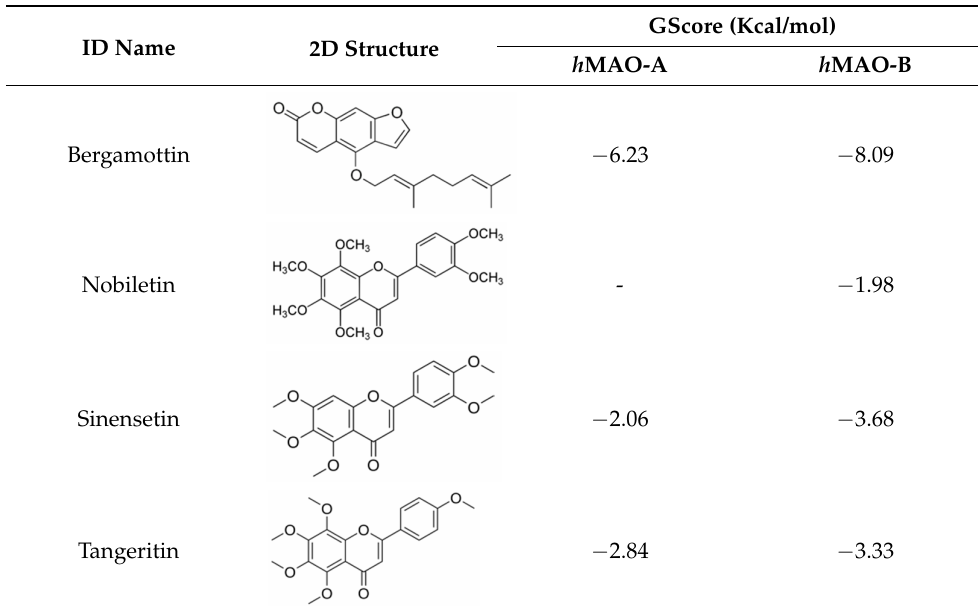
Table 1. Docking GScore value of selected BEO non-chiral compounds screened against h MAO-A and h